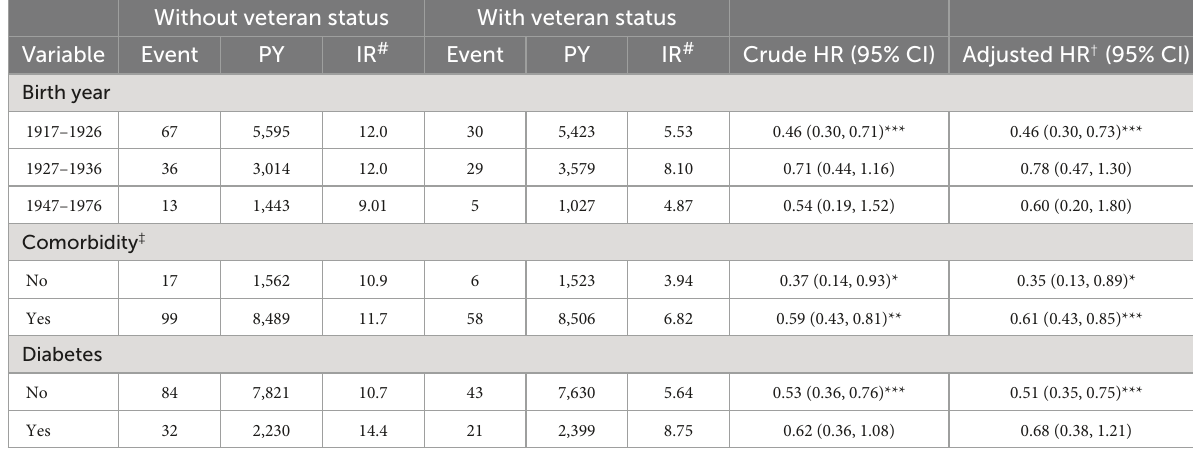
TABLE 3 Comparison of incidence and hazard ratio of cancer stratified by birth year and comorbidity between groups with and without veteran status on the propensity score matched cohorts. Without veteran status With veteran status Variable